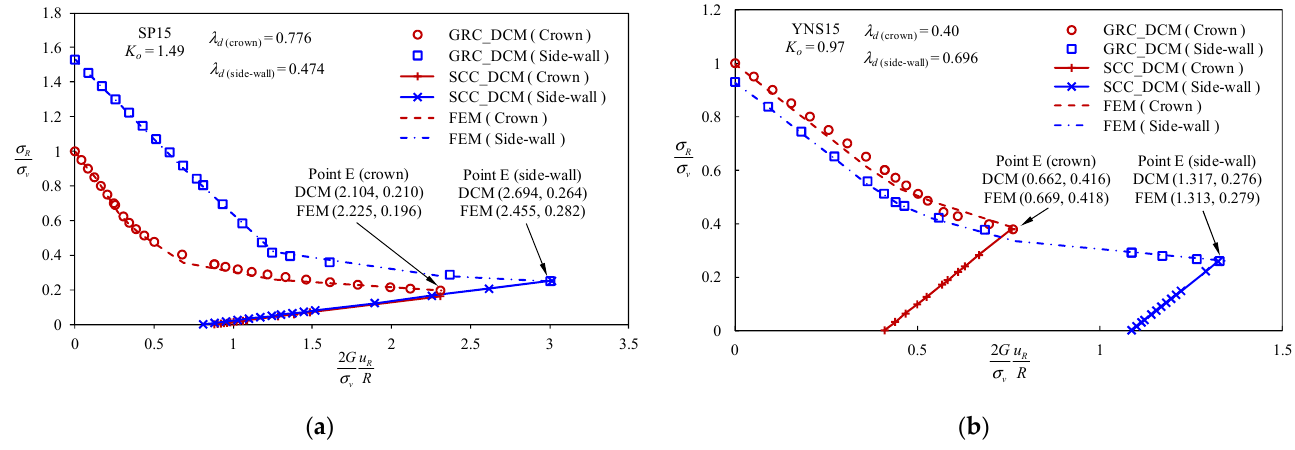
Figure 10. Comparison of the interaction behavior of support-ground between DCM and FEM at the section of observation ( a ) SP15 of the New Nanao tunnel, and ( b ) YNS15 of the New Youngchun tunnel.